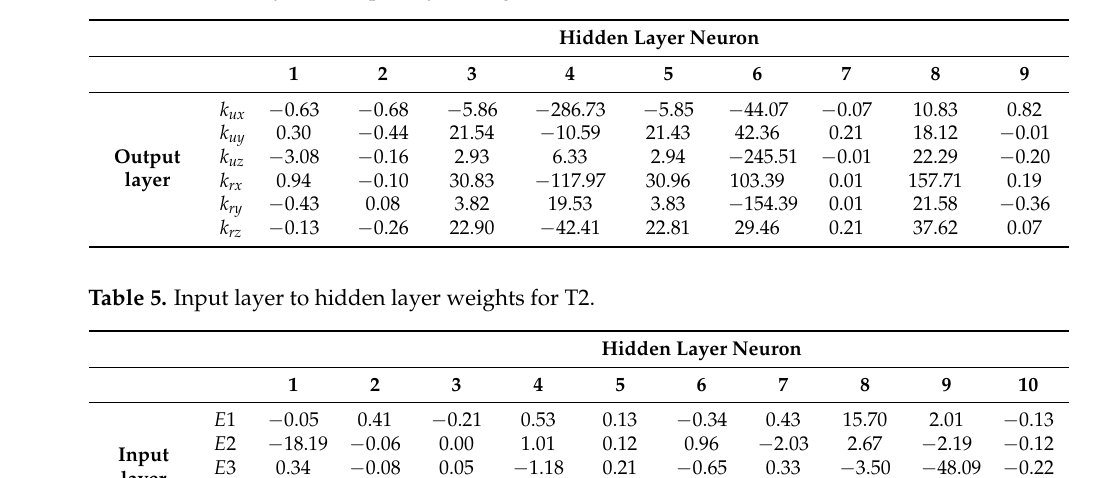
Table 4. Hidden layer to output layer weights for T1.